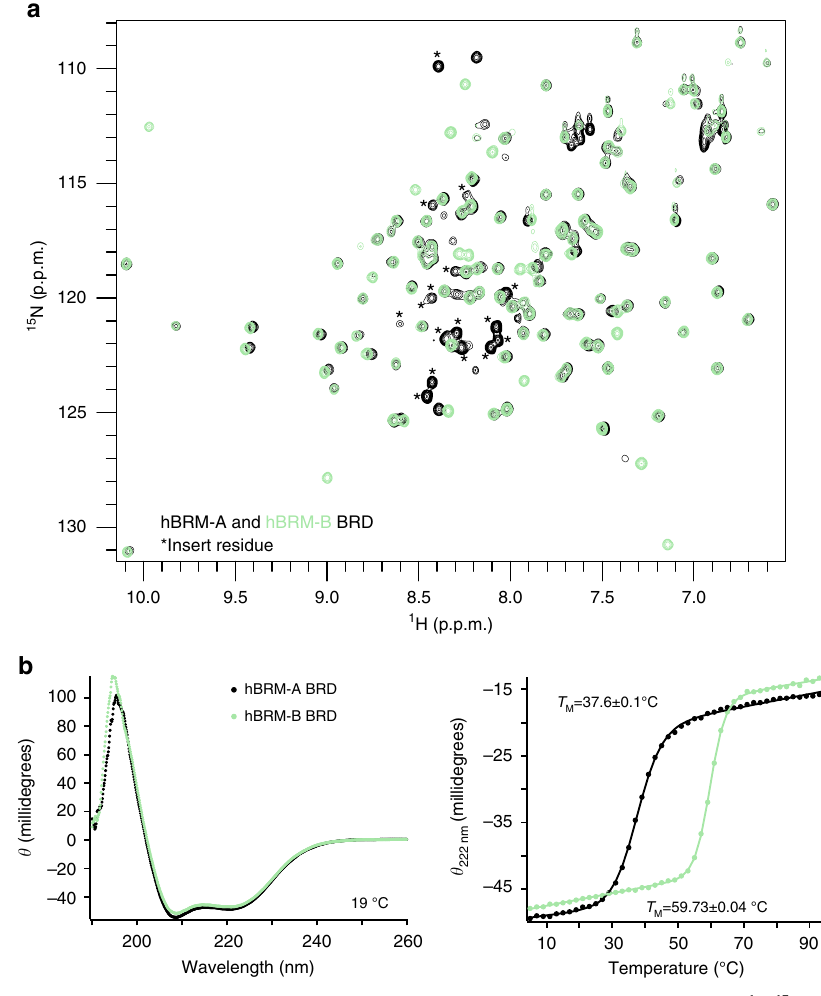
Figure 2 | The hBRM BRD splice variants have the same overall fold but different thermal stability. ( a ) Overlay of 1 H- 15 N HSQC spectra of 15 N-hBRM-A (black) and 15 N-hBRM-B (green) BRDs. Resonances corresponding to the extra 18-aa in hBRM-A are labelled (*). ( b ) CD data collected on the two splice variants of the hBRM BRD. CD spectra collected at 19 (cid:2) C on the hBRM-A (black) and hBRM-B (green) BRDs confirm an a -helical structure for both splice variants (left). Thermal denaturation curves are plotted as the raw ellipticity measured at 222nm as a function of temperature and show that the hBRM-A BRD curve (black) is shifted by B 20 (cid:2) C from the hBRM-B BRD curve (green) (right). The thermal denaturation curves were fit to the Gibbs–Helmholtz equation for unfolding as a function of temperature (solid lines), and the fit values along with the error in the fit for the melting temperatures ( T M ) are